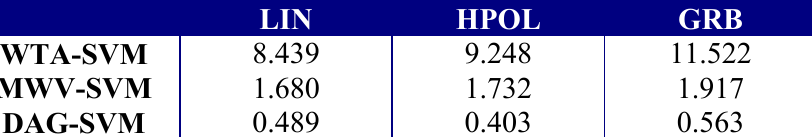
Table 7. Computation Time of SVMs